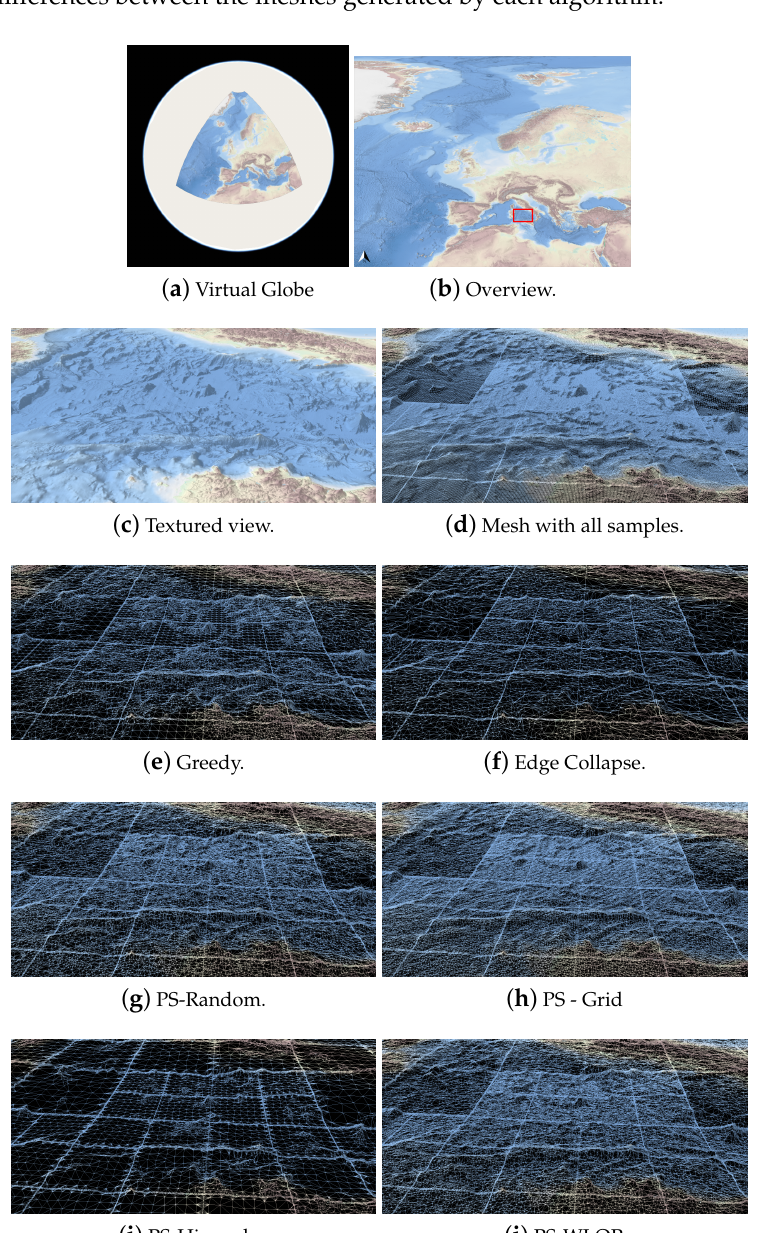
Figure 9. Visualization of the pyramidal LOD structure in a web viewer. The map on a virtual globe can be seen in ( a ), while in ( b ), we show the map in geographic coordinates, and mark in red the area depicted in ( c – j ), with approximate geographical boundaries at N 9.7 E 42 and N 15 E 37.5. Starting with the textured view in ( c ), we show the mesh resulting from triangulating the original data ( d ) and the meshes/tiles resulting from visualizing the data structures computed in Section 5.2 from the same point of view using the different